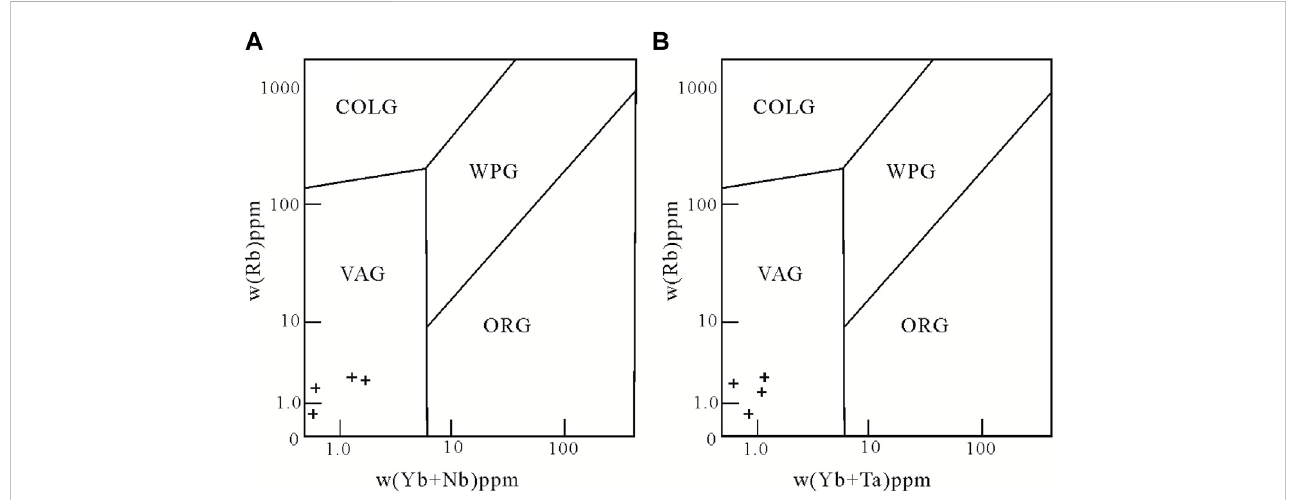
FIGURE 12 Trace element tectonic discrimination diagrams for granites (modi fi ed from Pearce, 1984): Yb+Nb-Rb (A) ; Yb+Ta-Rb (B) tectonic discrimination diagrams; VAG-Volcanic arc granite; ORG-Ocean ridge granite; WPG-Within-plate granite; COLG-Collision